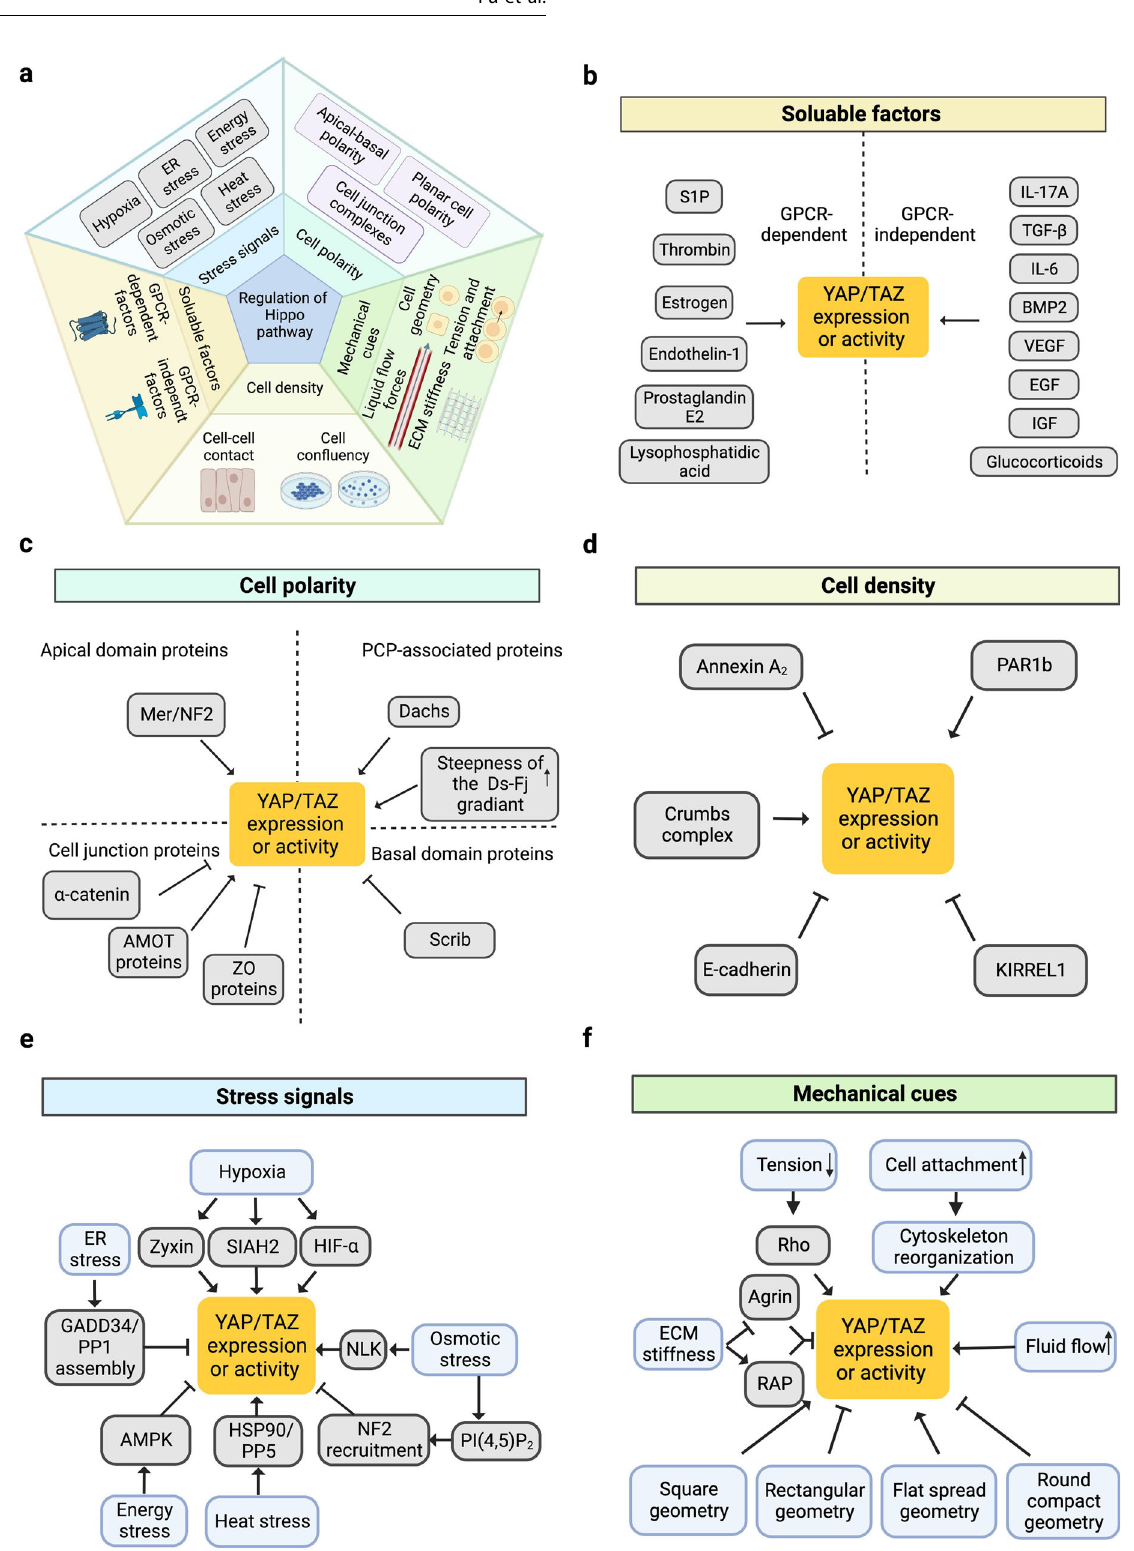
Fig. 3 Regulation of the Hippo pathway by upstream signals. a Five subgroups of upstream signals including cell polarity, mechanical cues, cell density, soluble factors, and stress signals are responsible for the regulation of Hippo pathway. b – f The detailed upstream signals of Hippo pathway in every subgroup